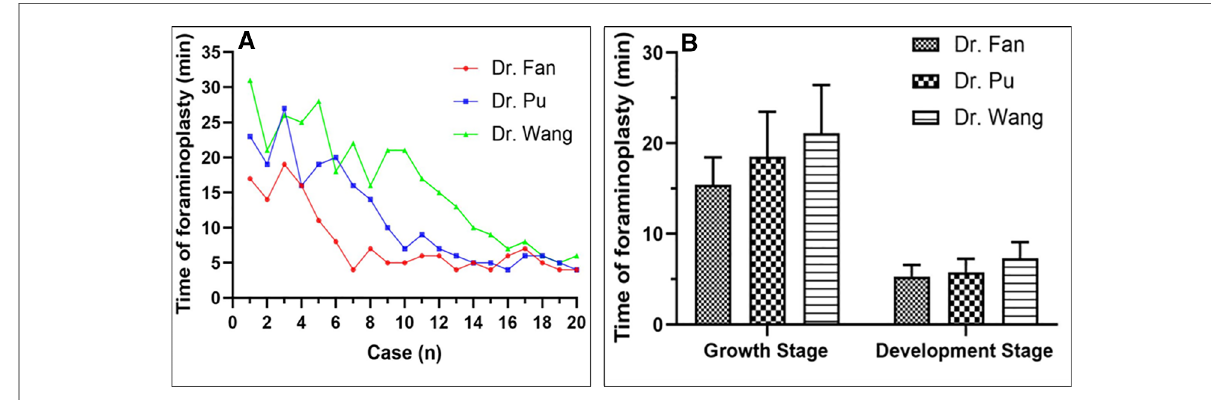
FIGURE 3 Time of foraminoplasty and number of surgical cases among three surgeons. ( A ): With the increase in the number of operations completed, the time spent by all three surgeons on intervertebral foraminoplasty decreased. ( B ): There was no signi fi cant difference in foraminoplasty time among these three surgeons during the same growing period.